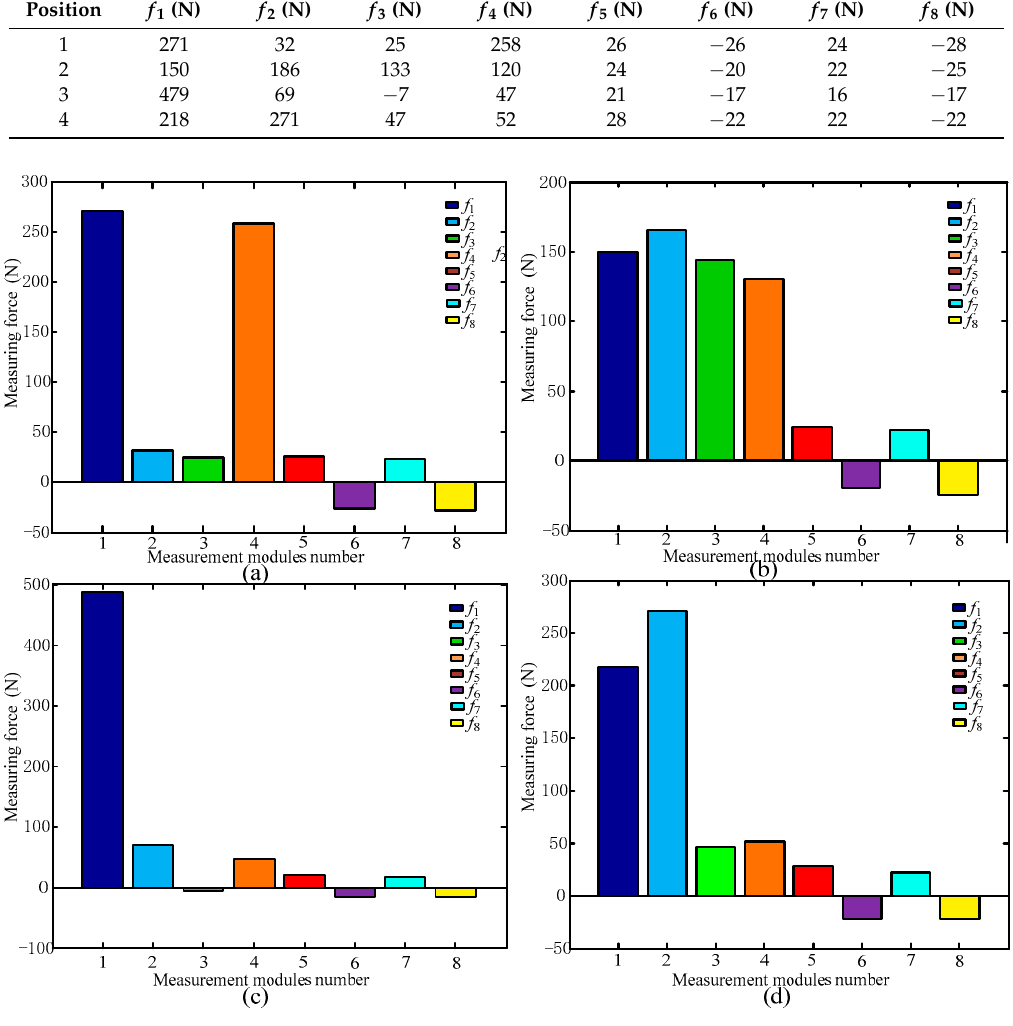
Figure 17. Six-dimensional sensor measurement module outputs with a person standing at ( a ) Position 1; ( b ) Position 2; ( c ) Position 3; and ( d ) Position 4.